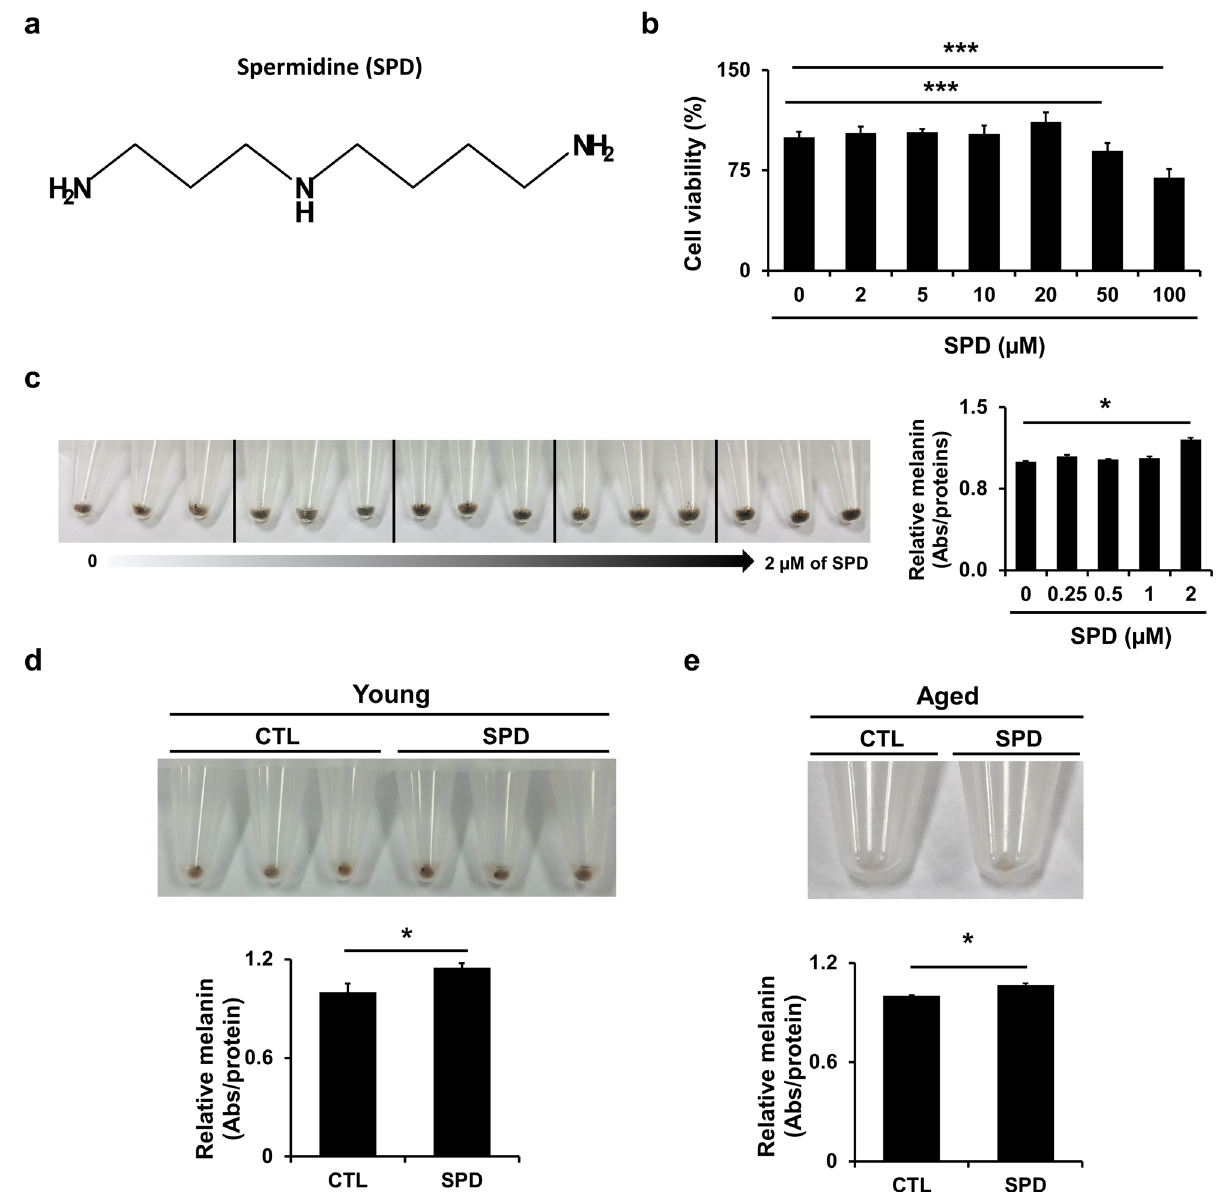
Figure 1. Spermidine (SPD) treatment increases melanin production. ( a ) Scheme of the chemical structure of SPD. ( b ) Cell viability of MNT-1 cells was evaluated using 3-(4,5-dimethylthiazol-2-yl)-2,5-diphenyltetrazolium bromide (MTT) assays after 24 h of SPD treatment. ( c ) Melanin levels in MNT-1 cells treated with 0, 0.25, 0.5, 1, and 2 μM of SPD for 10 days were measured at 450 nm. The data are representative of two independent experiments. ( d , e ) Melanin levels in young and aged primary human melanocyte cells treated with 1 μM of SPD for 10 days were measured at 450 nm. The data are representative of three independent experiments. CTL: control, *P < 0.05 , **P < 0.01 , *** P <